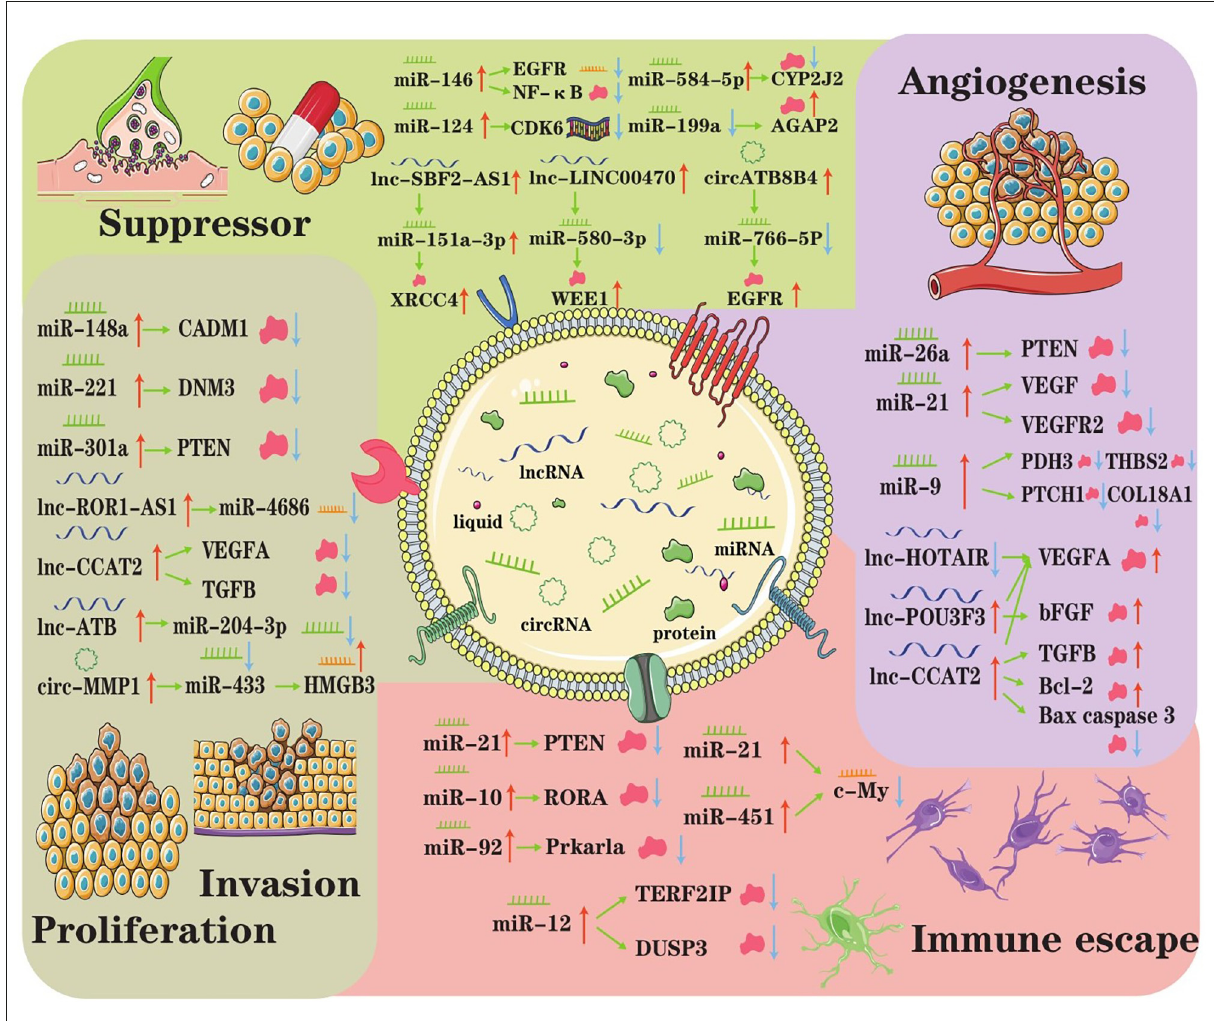
FIGURE2 The underlying regulatory axes and molecular mechanisms of exosomal ncRNAs in CNS tumor. In the tumor microenvironment, intercellular communication can be achieved by exosomes. Subsequently, exosomal ncRNAs exert important roles in modulating treatment resistance, proliferation/invasion, angiogenesis, and immune